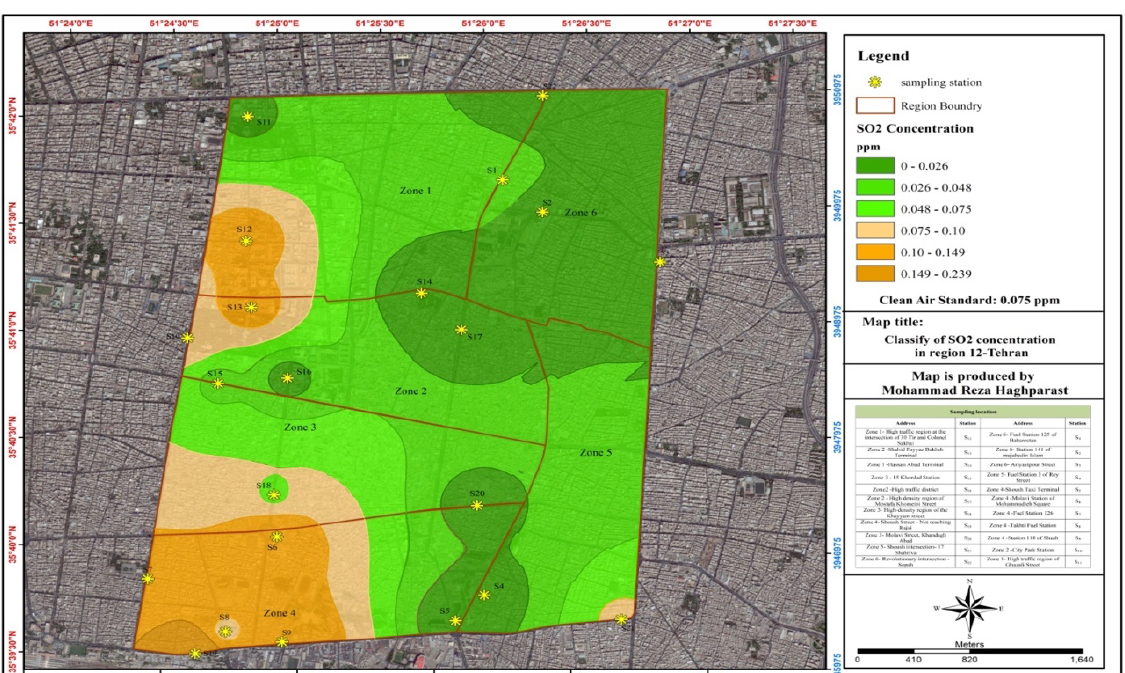
Figure 3. Zoning sulfur dioxide concentration in the region on January, 2018 The concentration of CO pollutants in the zoning indicates that the area was below the standard clean air standard. As can be seen from the figure 5 the concentration of O throughout the area is below the standard clean air